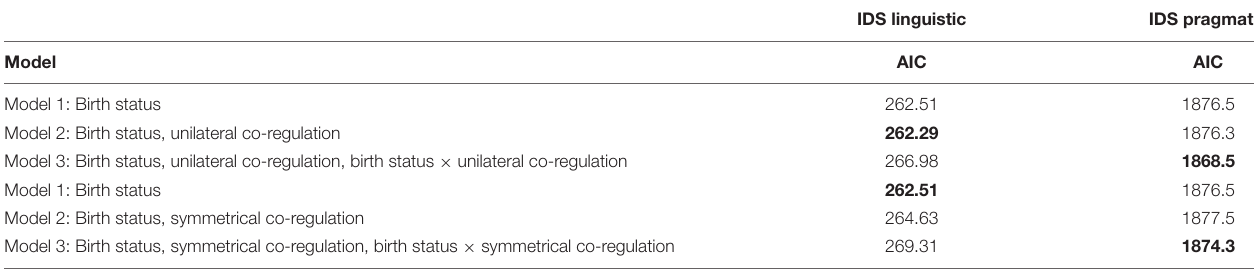
TABLE 3 | Model comparison, effects of birth status, and dyadic co-regulation: